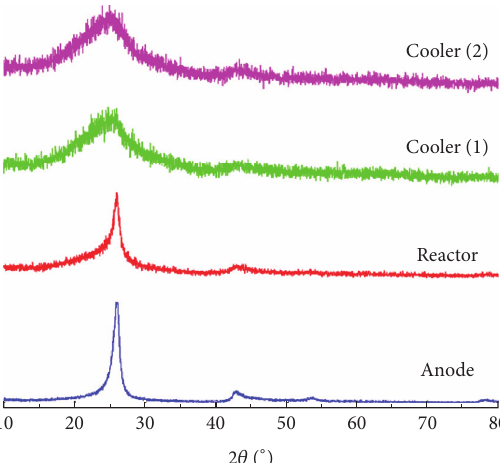
Figure 6: 13 C CP/MAS NMR spectra of the carbon residues col- lected at different points in the Ar plasma apparatus. The hydrogen contents of each sample (obtained by elemental analysis) are also